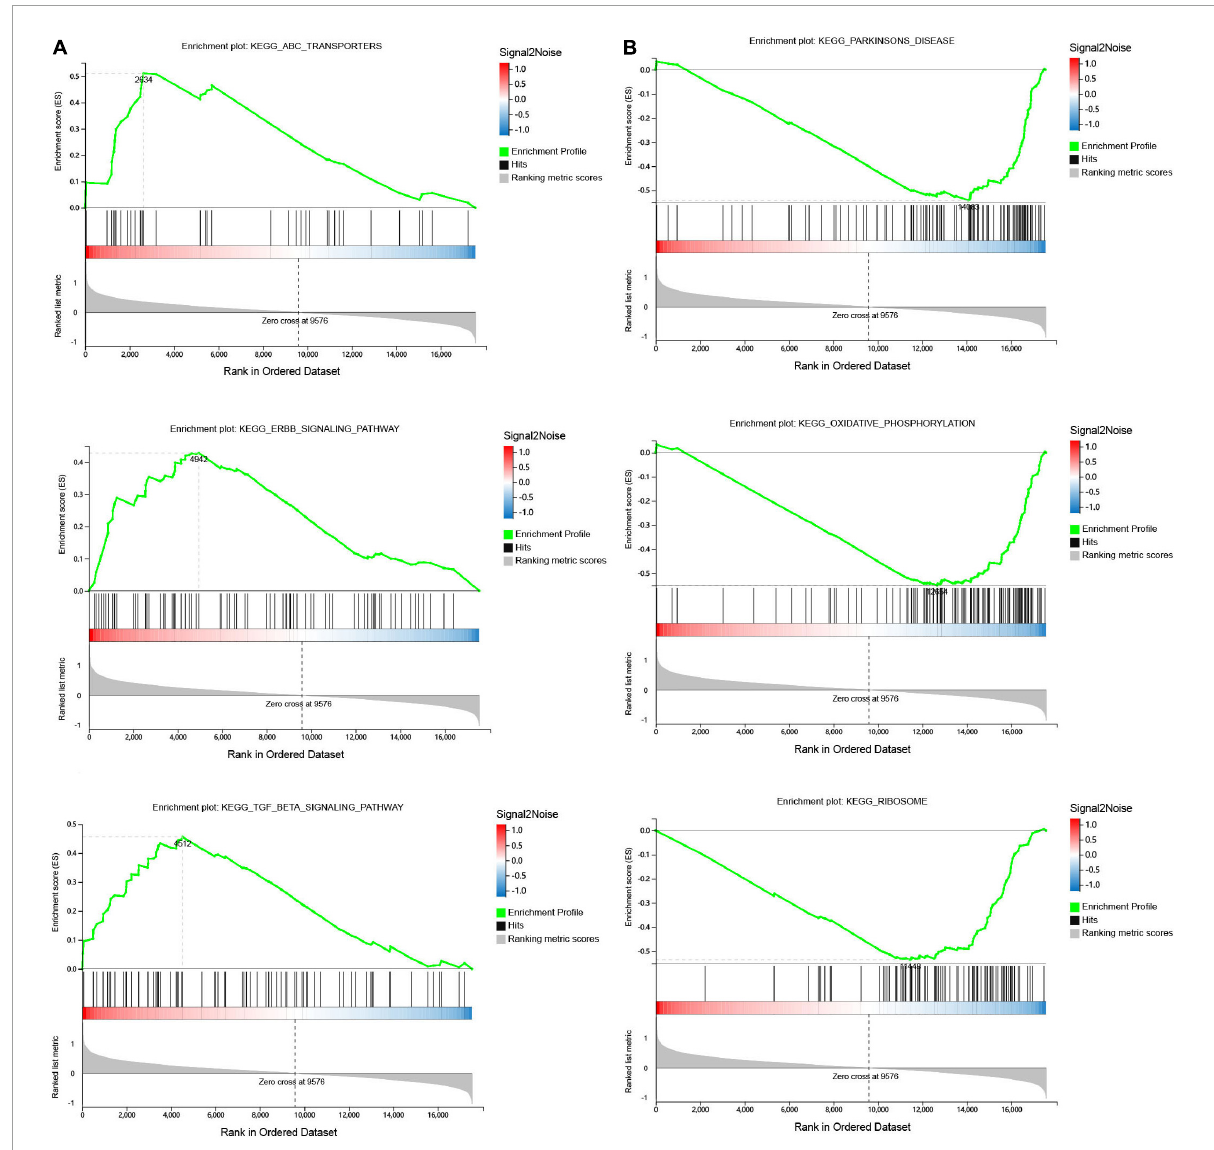
FIGURE4 Gene set enrichment analysis (GSEA) of differentially expressed genes (DEGs) using the GSEA Kyoto encyclopedia of genes and genomes (KEGG) pathways database. (A) The top three enriched up-regulated KEGG pathway sets. (B) The top three enriched down-regulated KEGG pathway